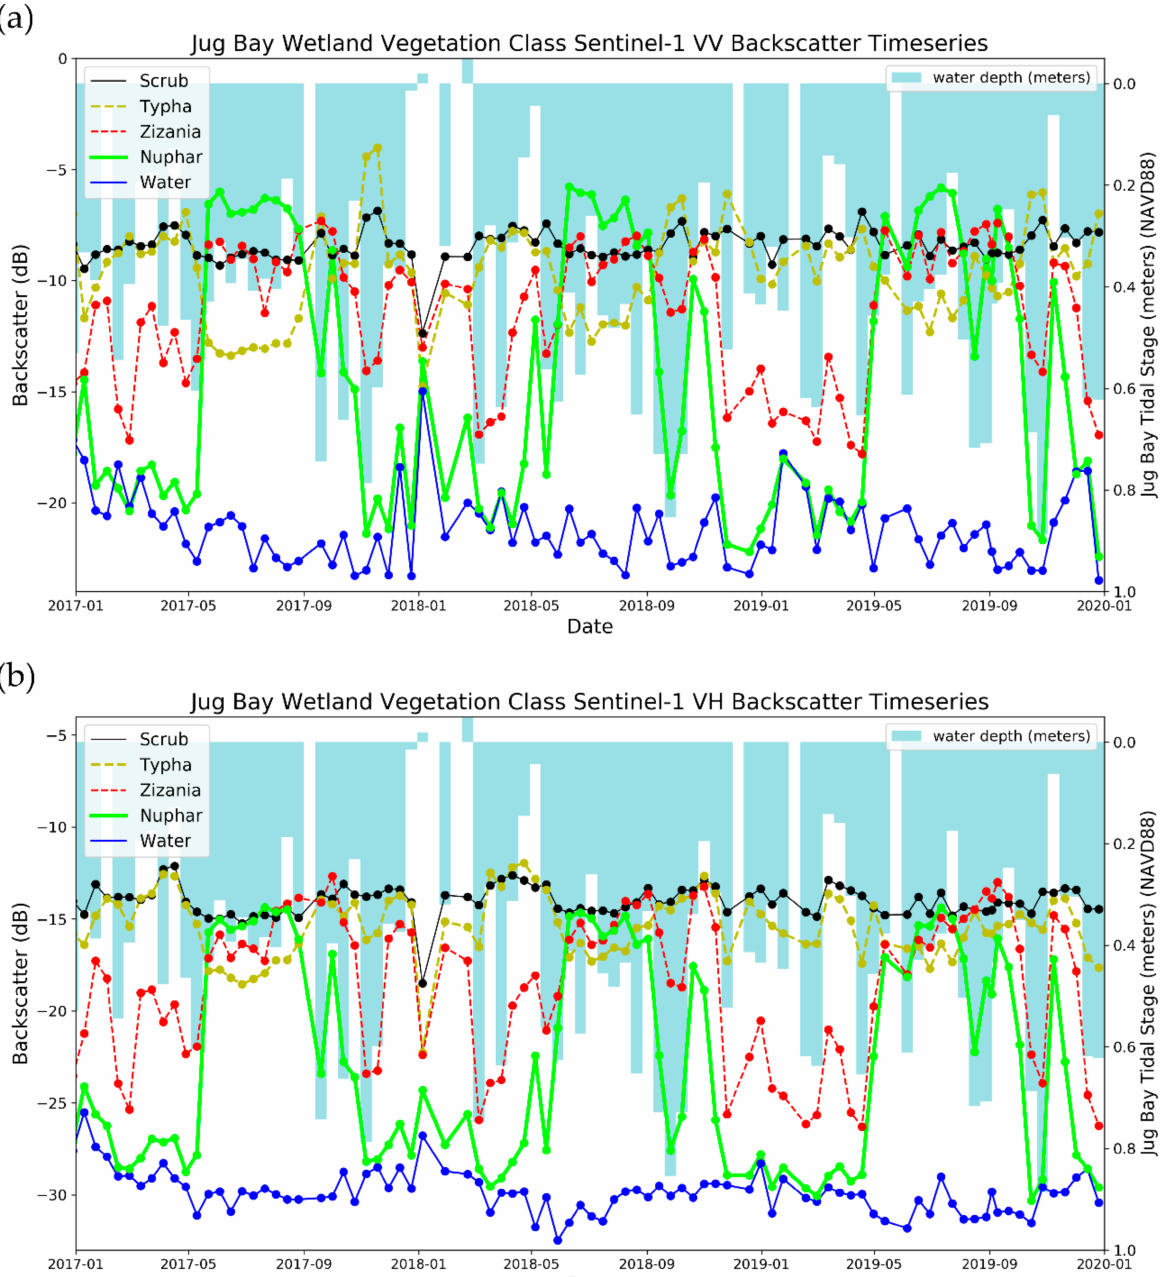
Figure 7. Jug Bay wetland vegetation class Sentinel-1 VV and VH polarized backscatter time-series from 2017–2019 (panels ( a ) and ( b ), respectively). Dates are shown in numeric year-month format. Water depth (in meters) is the NOAA tide gauge at Solomon’s Island (ID: 8577330) calibrated to in-marsh water level changes observed with Onset HOBO sensors from October 2019 to December 2019. Calibrations include time and water depth adjustments. All series represent spatial mean backscatter from Jug Bay wetland classes originally published in Swarth et al. (2013) and updated in Lamb et al. (2019). The wetlands classes are as follows: solid black series = shrub-scrub, dashed gold series = Typha spp., red dashed series = Zizania aquatica , solid green series = Nuphar lutea , solid blue = open